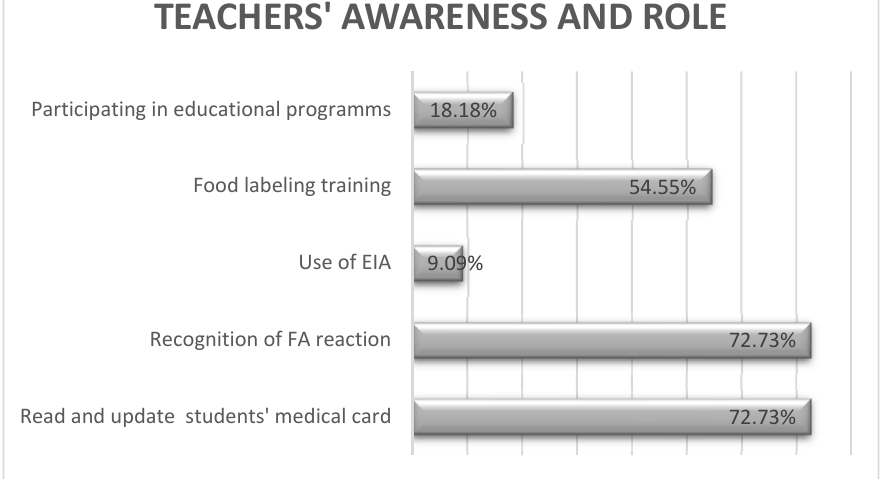
Figure 3. Percent of teachers that have different skills and knowledge about FA children in the school environment.